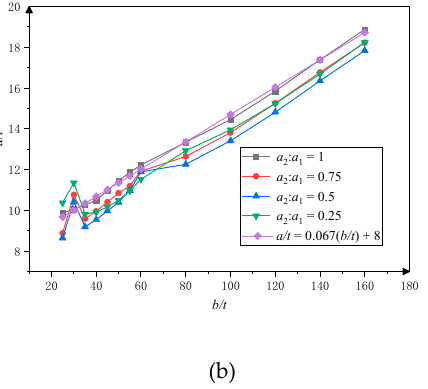
Figure 10. Minimum edge stiffener width − thickness ratios under l/t = b/t and k = 4.26: (a) l/t = b/t ; (b) k = 4.26. Table 4. Statistical metrics of Equations (5) and (6).